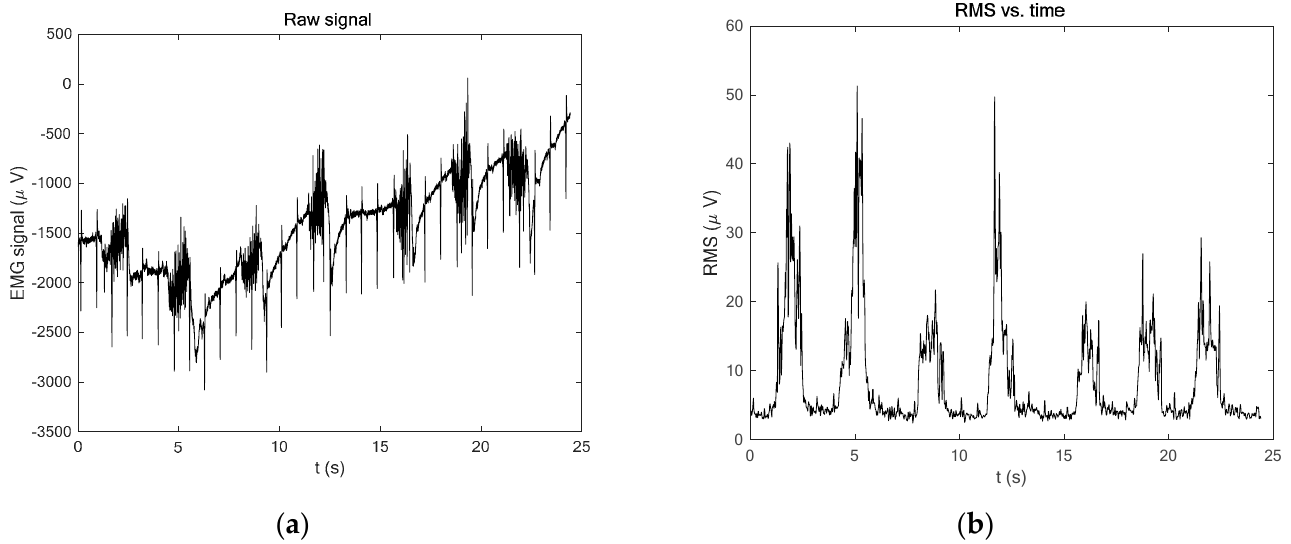
Figure 16. Example of analysis, ( a ) a raw superimposed EMG measured on the left pectoral muscle with very high ECG signal contribution, ( b ) RMS-80/40 EMG filtered by HP Butterworth filter ( f c = 200 Hz).